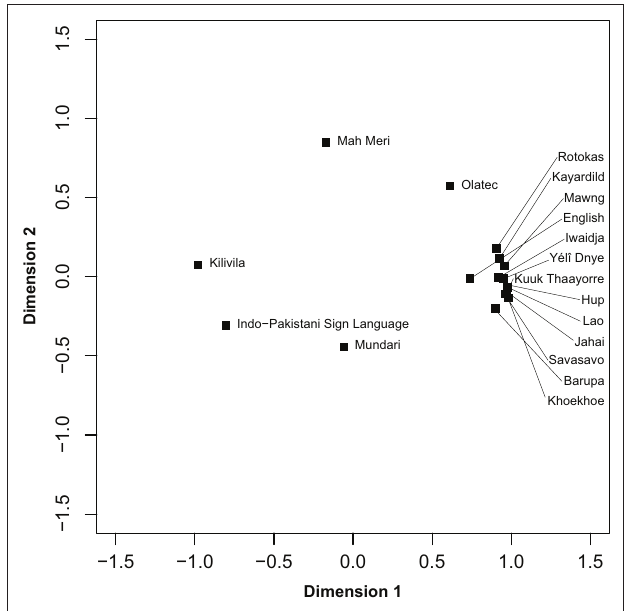
FigurE 3 | Factor analysis of languages according to the overall pattern of categorization of reciprocal